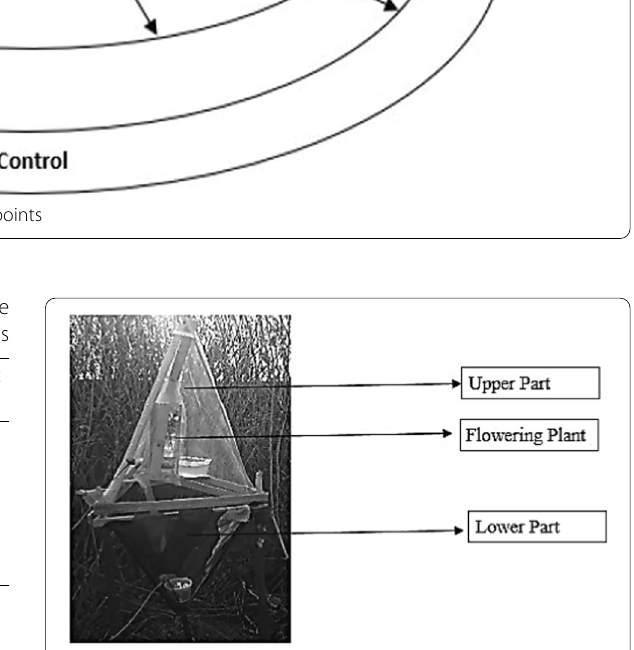
Fig. 3 Locally designed malaise trap used for collection of flying